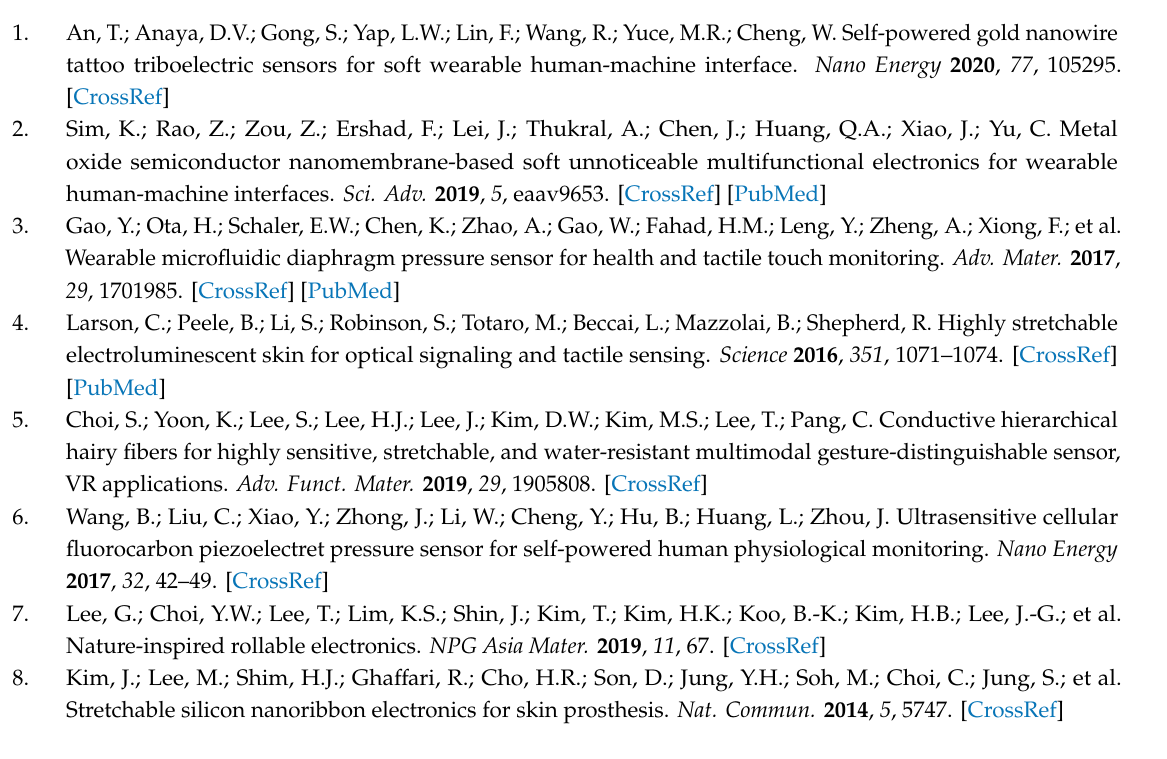
Table S1: Comparisons of the GFs, maximum tensile strains, pressure insensitivities (relative resistance changes under normal pressures), and adhesion strengths between the developed sensor in this work and those in similar previous studies, Figure S1: Schematic of the fabrication procedure of the pressure-insensitive self-attachable flexible strain sensor, Figure S2: Sheet resistance and MWCNT layer thickness ( a ) and conductivity ( b ) of the self-attachable flexible strain sensors as a function of the coating dose of the MWCNTs, Figure S3: Adhesion strengths of SCMs (coating dose: 155.3 µ g cm − 2 ) against glass substrates with di ff erent roughness (root mean square (RMS): 0.05, 0.33, 1.89, and 5.18 µ m), Figure S4: GFs of SCMs with di ff erent pillar stem diameters and SRs, Figure S5: Relative resistance change as a function of applied in-plane tensile and compressive strain, Figure S6: Attachment behavior of the SCM strain sensors. ( a ) Schematic illustration showing the di ff erent attachment modes of the SCM sensors to a PET substrate using the planar backside ( i ) and the frontside ( ii ) of the SCMs. ( b ) Photograph showing the di ff erent adhesion behaviors of the SCM sensors attached to a flexible PET substrate using its backside and frontside under bending stress, Figure S7: Demonstration of a self-attachable strain sensor for the monitoring application of human physical activities, Figure S8: Adhesion strengths, relative resistance changes for a normal pressure (100 kPa), and GFs for tensile strains (range: 0 to 80%) of five SCM samples (coating dose of MWCNTs: 155.3 µ g cm − 2